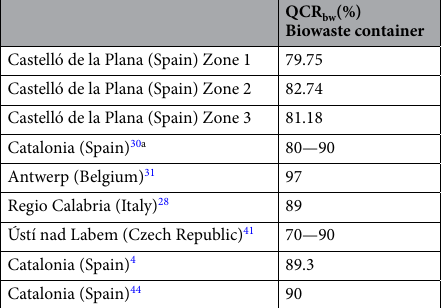
Table 3. Quality in container rate of biowaste in several regions around Europe. a In some cities in Catalonia QCR bw was 50–60%.